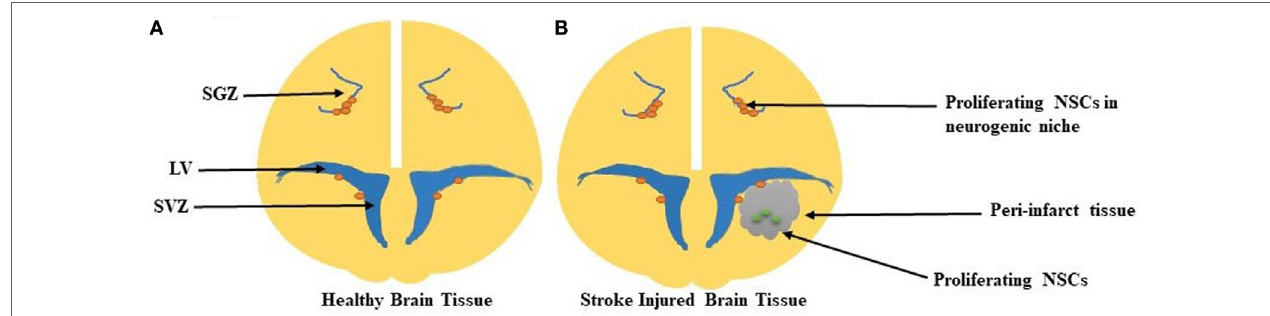
FiGURe 1 | (A) Healthy brain tissue with proliferating neural stem cells (NSCs) in the neurogenic niches of both the subgranular zone (SGZ) and subventricular zone (SVZ). The SVZ lines the lateral wall of the lateral ventricle (LV). (B) In the stroke-injured brain, the peri-infarct tissue, which contains the ischemic core, contains proliferating NSCs in this damaged